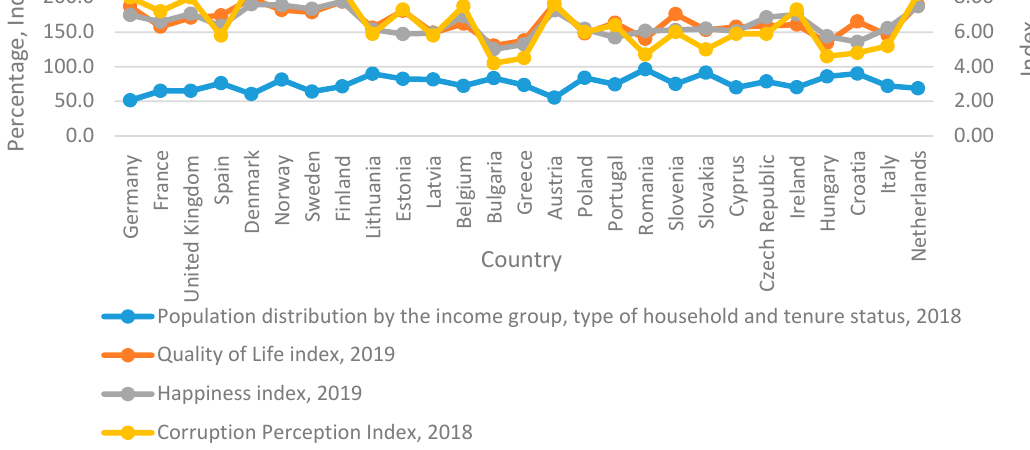
Figure 8. Correlation between the population distribution by the income group, type of household and tenure status, 2018, the quality of life, 2019, the happiness index, 2019, and the corruption perception index, 2018, of the 25 EU countries, the UK and Norway under evaluation.